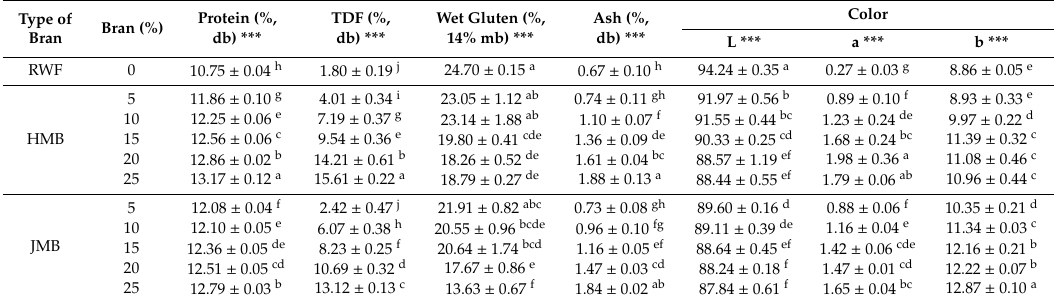
Figure 1. ( A ) Scanning electron microscopy (SEM, × 40) images and ( B ) particle size distribution of HMB or JMB. HMB: bran pulverized by hammer mill, JMB: bran pulverized by jet mill. Table 2. Protein, TDF, wet gluten, ash, and color characteristics of flours substituted with HMB or JMB at various levels (0%, 5%, 10%, 15%, 20%, and